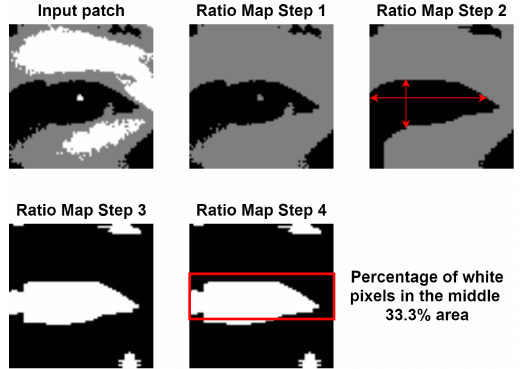
Figure 6. Visualisation of steps for eye ratio map score